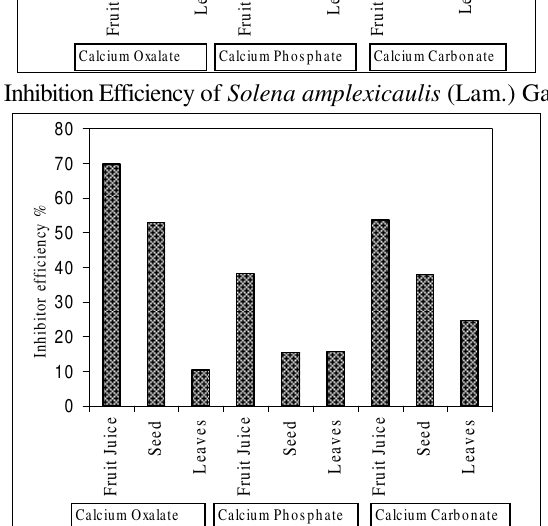
Figure 3 . Inhibition Efficiency of Solena amplexicaulis (Lam.) Gandhi ( P3 ).